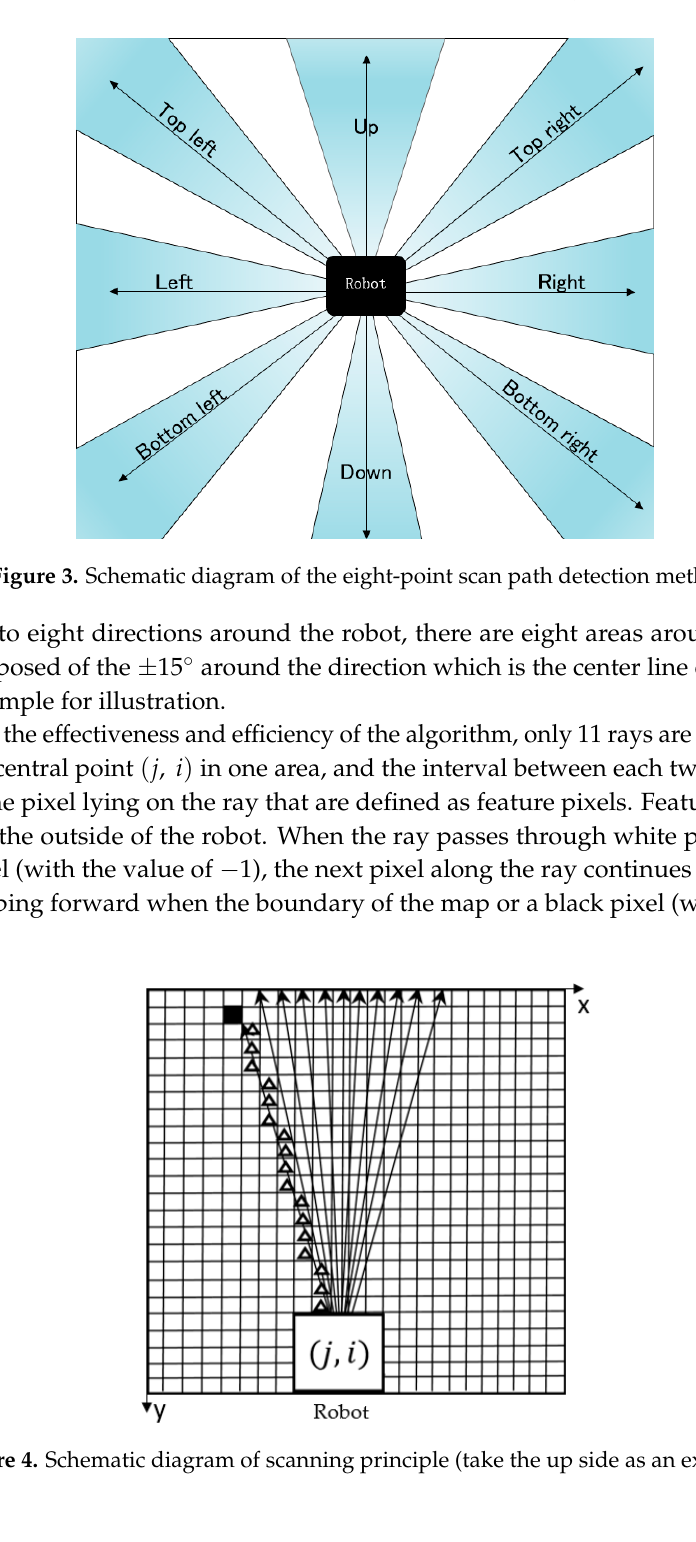
Figure 4. Schematic diagram of scanning principle (take the up side as an example).